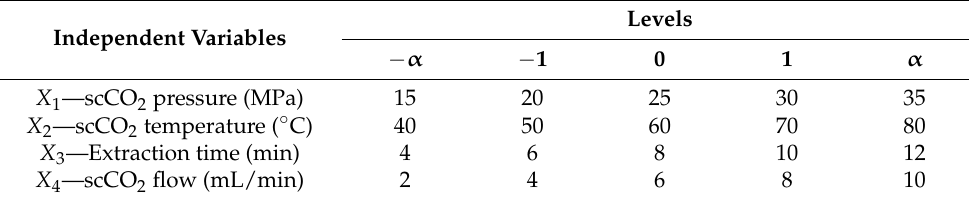
Table 6. Levels of variables in central composite rotatable design 2 4 experiment. Independent Variables